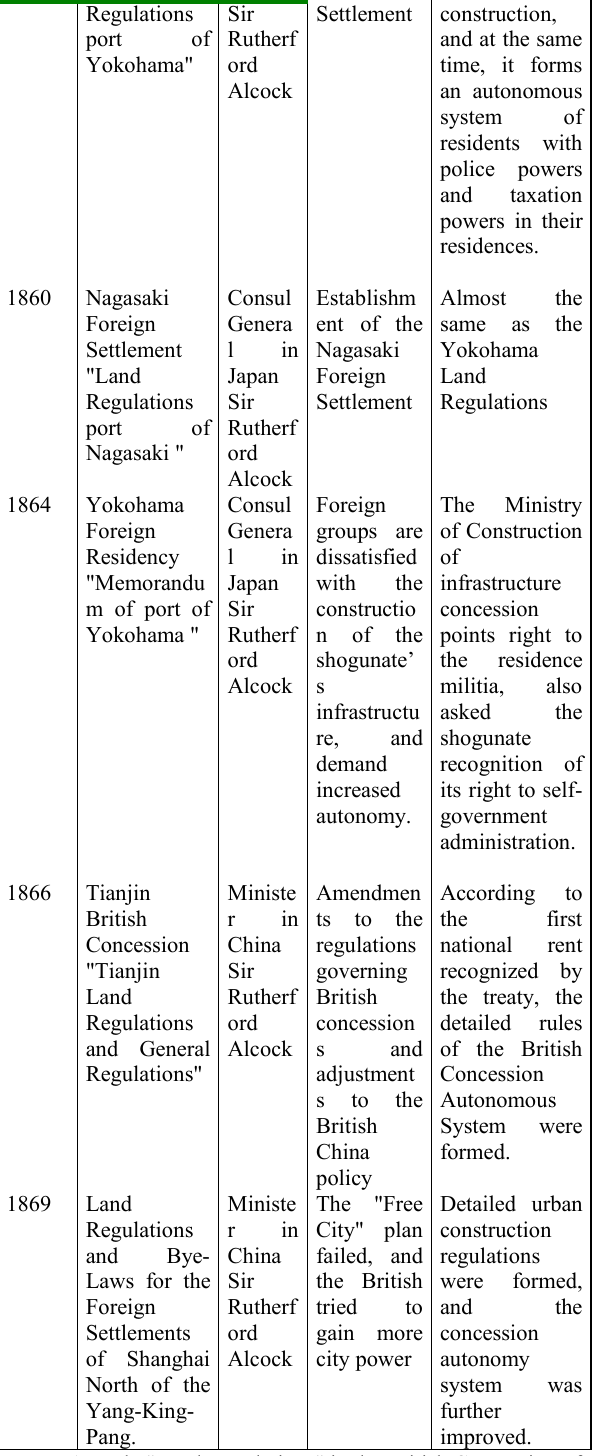
Table 1 . Early "Land Regulations" in the British Concession of East